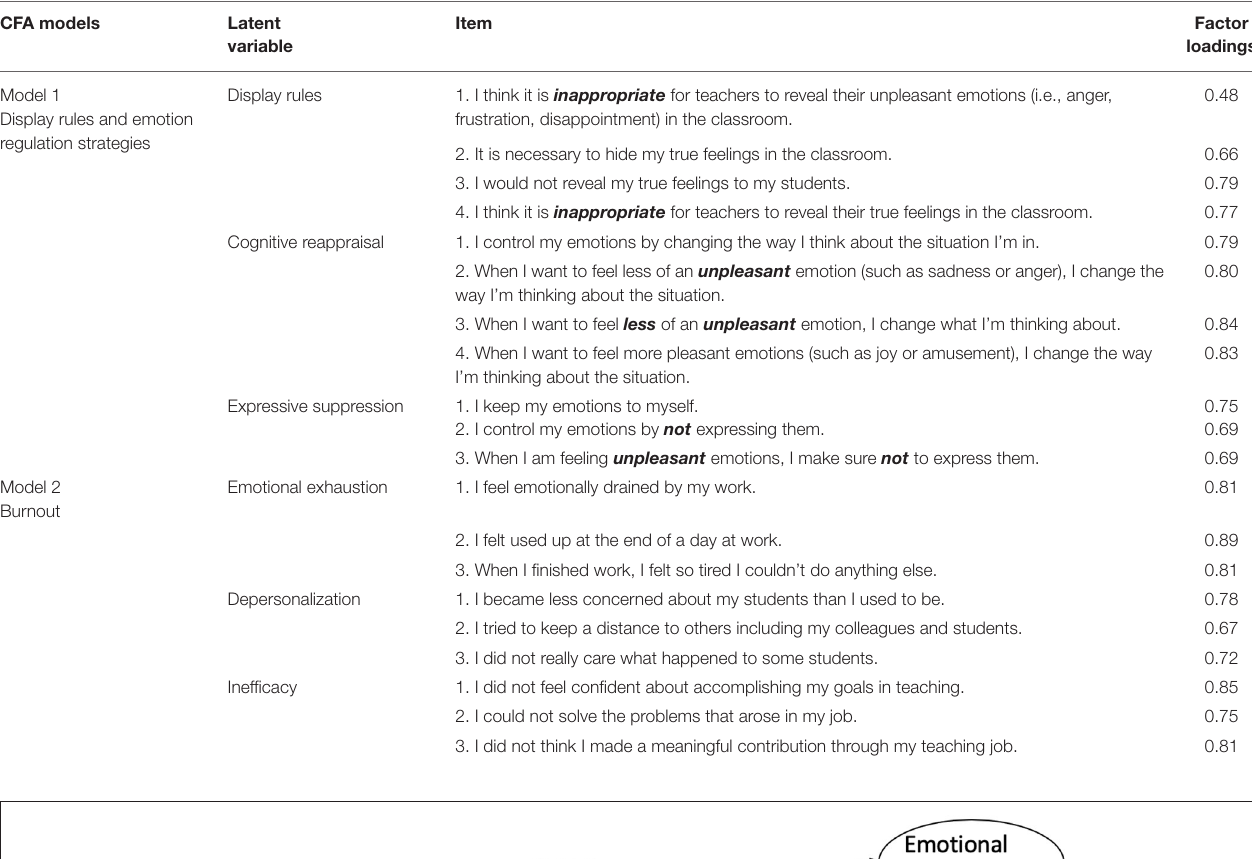
TABLE 2 | Standardized factor loadings for the items in the CFA models.